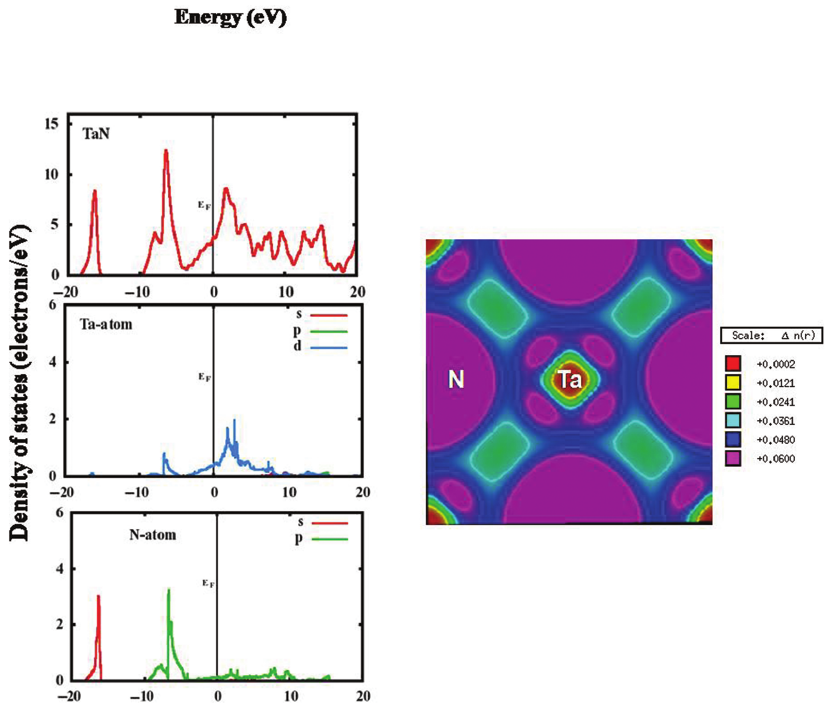
Figure 7: Electronic DOS and 2D charge density of NbN.